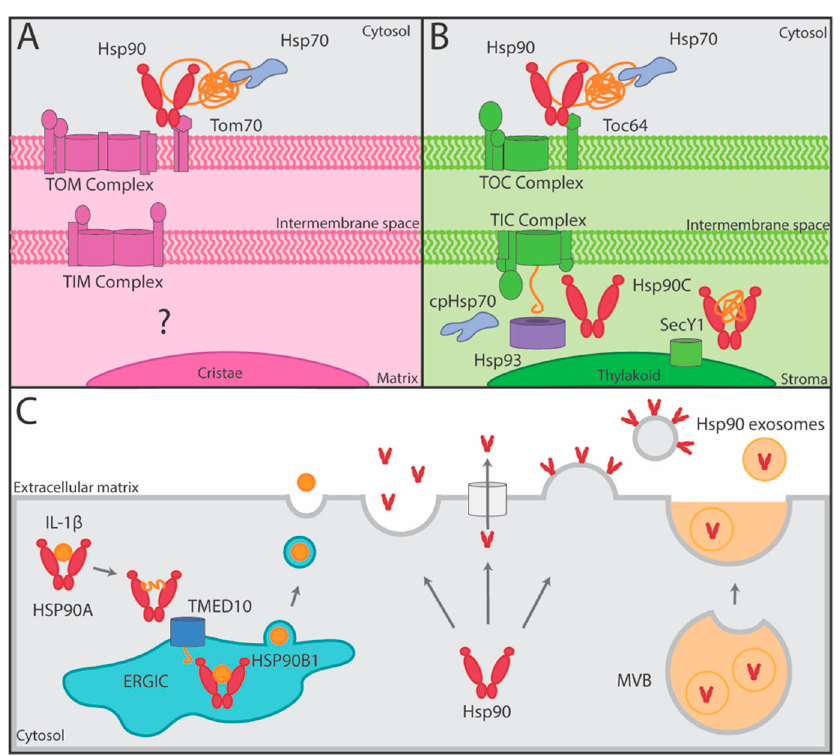
Figure 3. The role of Hsp90 in mitochondrial and chloroplast import as well as unconventional protein secretion (UPS). ( A ) Hsp90 with the aid of Hsp70 delivers preproteins to the TOM complex in the outer membrane of mitochondria through interactions with the TPR domain (hexagon) of peripherally associated Tom70 [43,45]. ( B ) Hsp90 with the aid of Hsp70 delivers preproteins to the